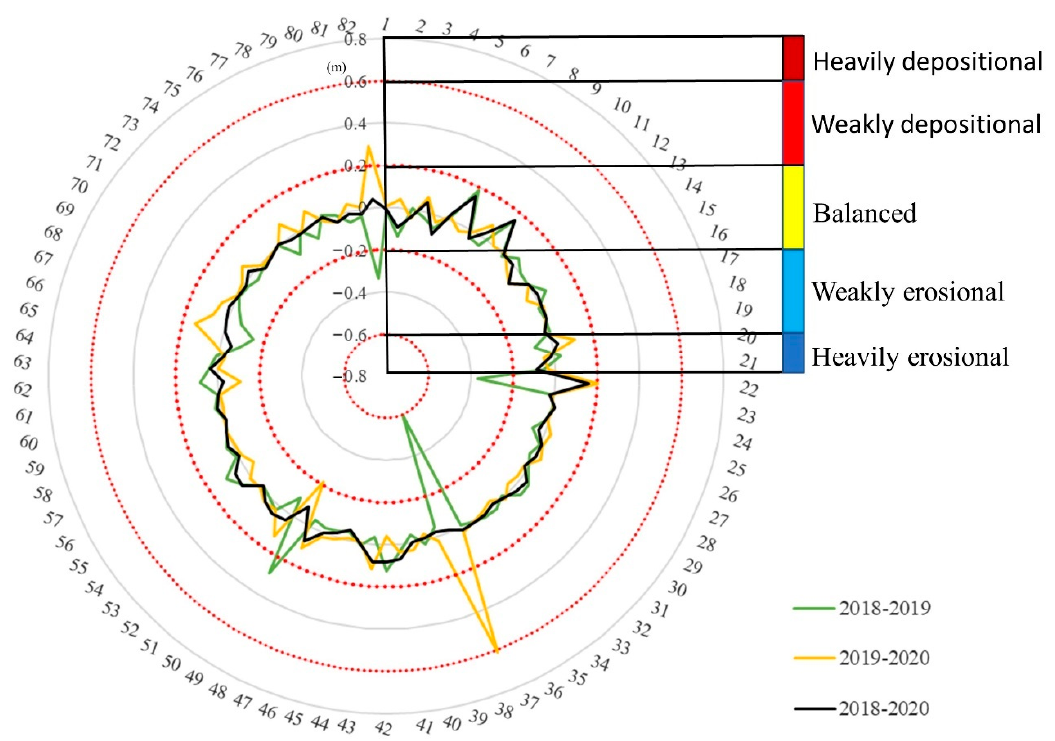
Figure 5. Calculation results of the TCI (the differently coloured solid lines represent the results of the calculations for different years, and the red dashed lines are the standard lines for assessing the TCI strength levels).